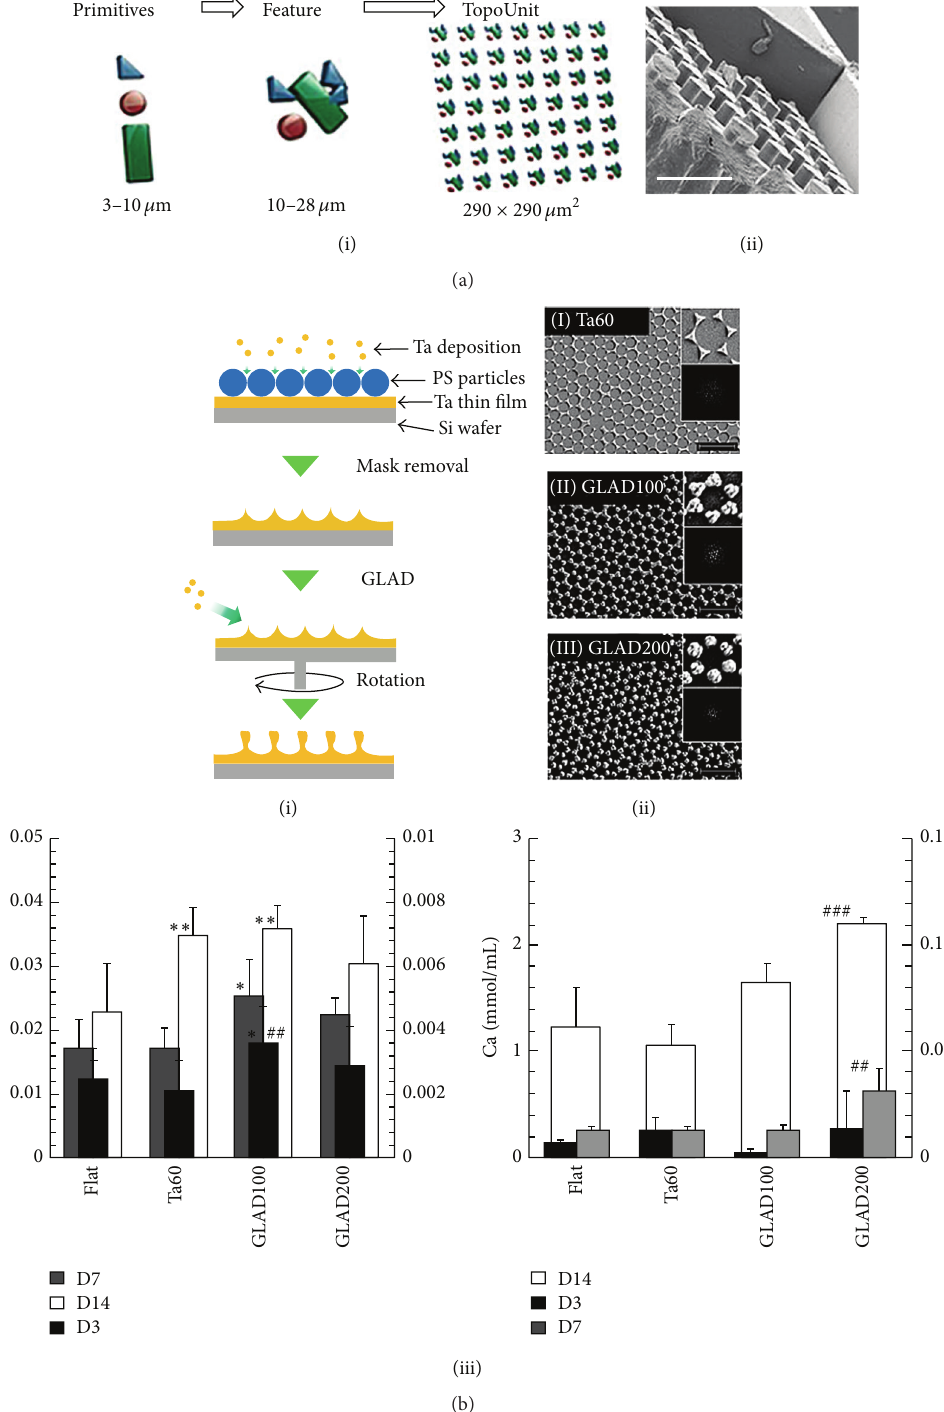
Figure 3: (a) An algorithm-based topographical chip. (i) Fabrication of the topographical chip (poly(lactic acid)) was based on the unique mask design using mixed primitives (circles, triangles, and rectangles). (ii) SEM images of a section of the patterned feature (scale bar: 50 𝜇 m). (b) Fabrication of micropillar array with GLAD technique. (i) Fabrication of tantalum (Ta) nanotopographies using a combination of colloidal self-assembly, colloidal lithography, and glancing angle deposition (GLAD) techniques. After assemble 722 nm poly(styrene) colloids, 60 nm Ta (Ta60) was sputtered, and then mask was removed, and GLAD of Ta was done for increasing of feature heights (GLAD100 or GLAD200). (ii) Scanning electron micrographs (SEMs) of Ta60, GLAD100, and GLAD200 (scale bar: 2 𝜇 m). (iii) Alkaline phosphatase (ALP) and calcium (Ca) quantification of osteogenic differentiated human adipose derived stem cells (hADSCs) on the surfaces by the cells were quantified with at least three samples ( 𝑛 > 3 ). # and ∗ indicate that there is a significant difference between FLAT and Ta60,